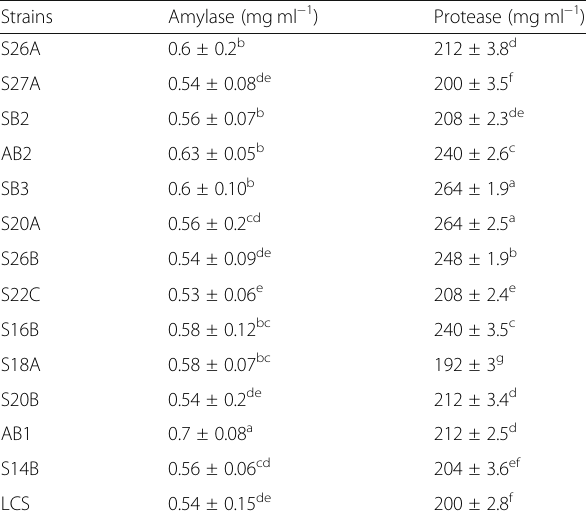
Values reported are mean±SD of triplicate experiments. Values within each row and column with different letter assigned are significantly different p